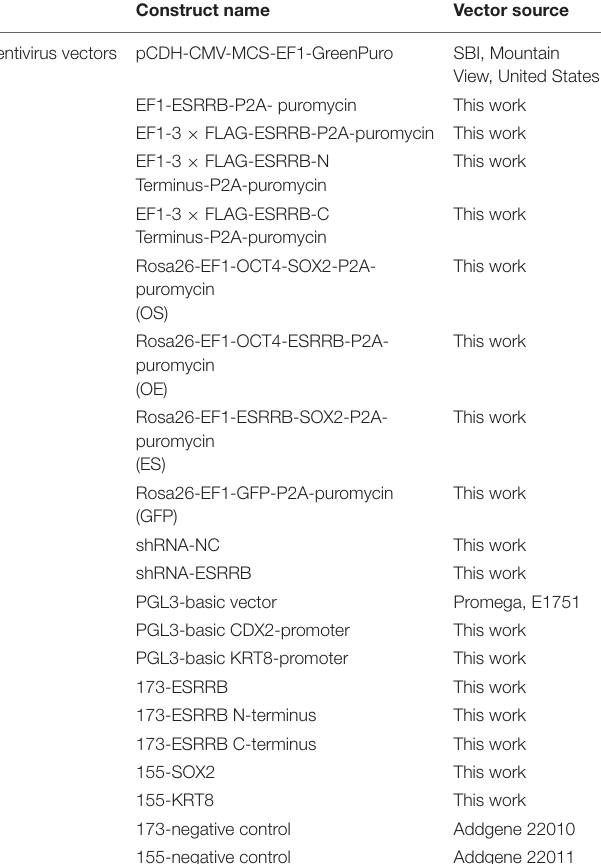
TABLE 1 | The DNA constructs used in this